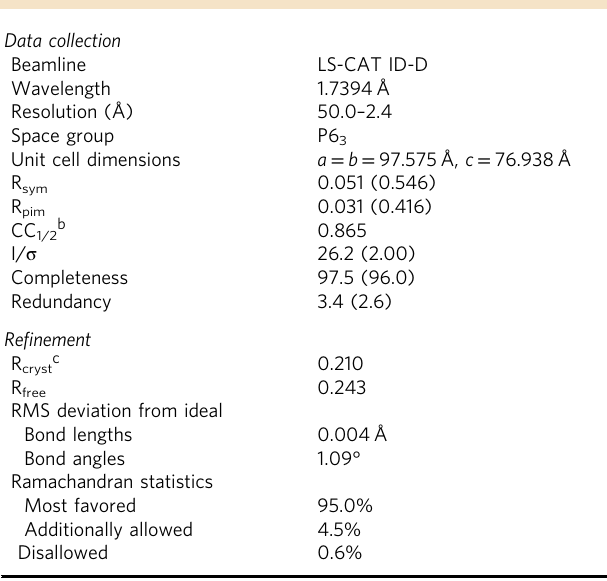
Table 1 Summary of crystallographic data collection and re fi nement statistics